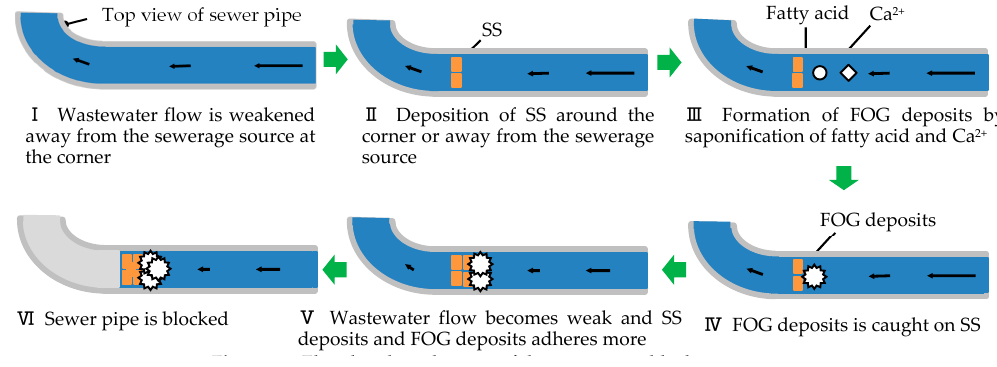
Figure 10. Elucidated mechanism of the sewer pipe blockage.